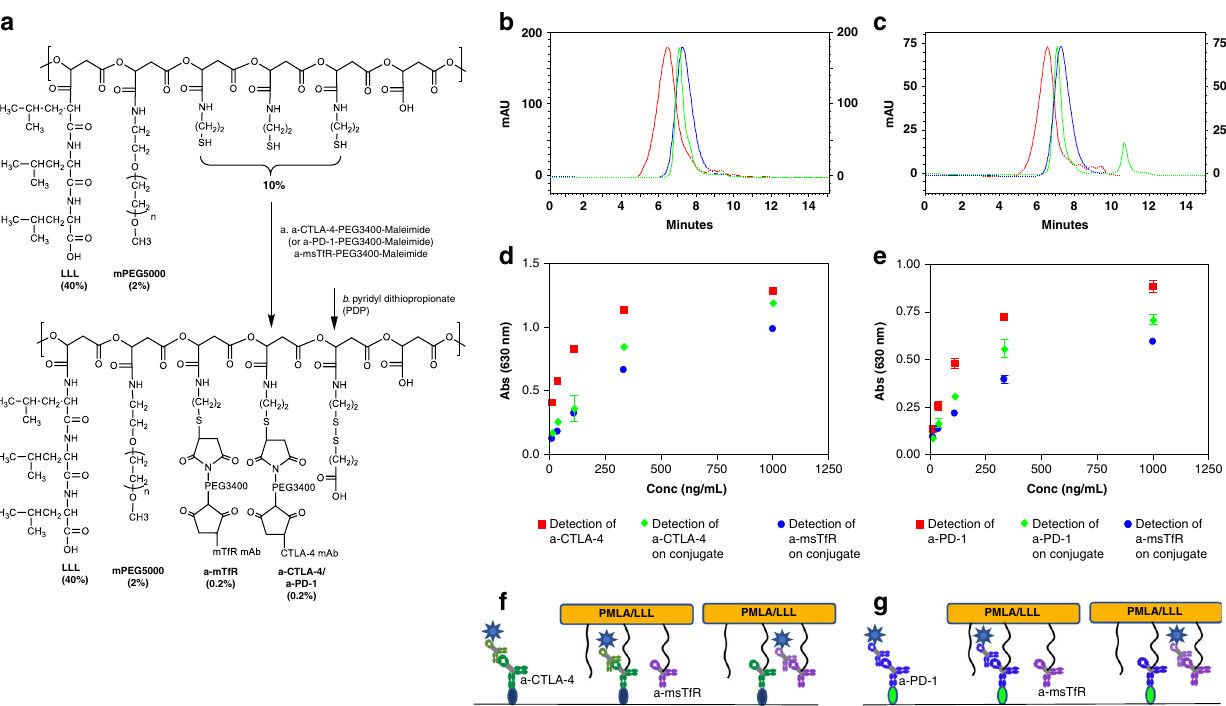
Fig. 1 Synthesis and characterization of NICs. a Synthesis of P/mPEG5000(2%)/LLL(40%)/a-msTfR(0.2%)/a-CTLA-4 (0.2%). The upper structure represents the pre-conjugate and the lower structure represents the fi nal nanoconjugate with antibodies and 3-(2-pyridyldithio) propionate (PDP). In some experiments, a-msTfR was substituted by AP-2 peptide (TFFYGGSRGKRNNFKTEEY). b SE-HPLC analysis of P/mPEG5000(2%)/LLL(40%)/a-msTfR (0.2%)/a-CTLA-4(0.2%). Right blue peak, the pre-conjugate P/mPEG5000(2%)/LLL(40%)/MEA(2%); middle (green) peak, a-CTLA-4; red peak, the synthesized P/mPEG5000(2%)/LLL(40%)/a-msTfR(0.2%)/a-CTLA-4(0.2%). c SE-HPLC analysis of P/mPEG5000(2%)/LLL(40%)/a-msTfR(0.2%)/a- PD-1(0.2%). Right blue peak, the pre-conjugate P/mPEG5000(2%)/LLL(40%)/MEA(2%); middle (green) peak, a-PD-1; red peak, the synthesized P/